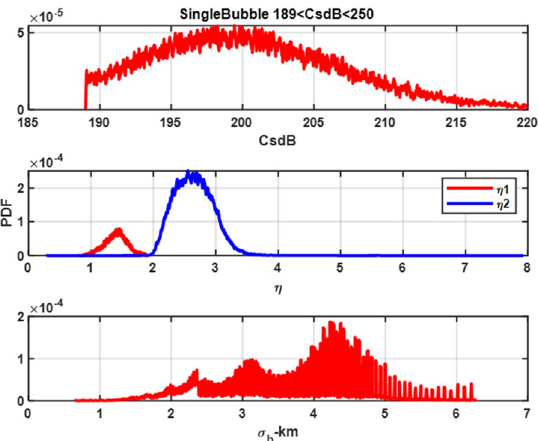
Fig. 5 Probability distributions of IPE parameters. ( CsdB upper frame, η 1 , η 2 , middle frame, σ b lower frame)